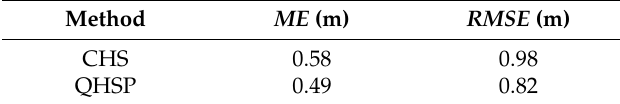
Table 3. Errors of constructed river channel at Wangmaogou catchment by using CHS and QHSP methods.